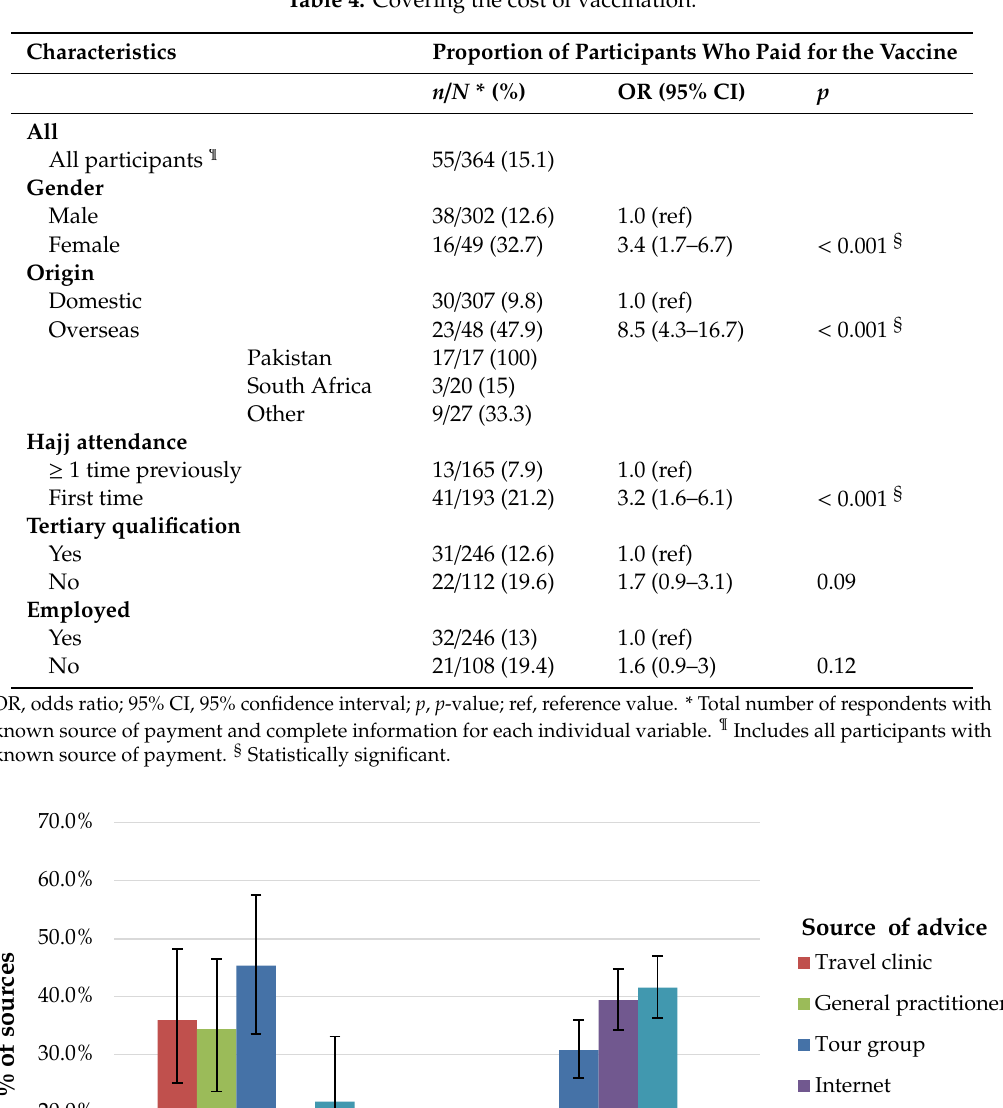
Table 4. Covering the cost of vaccination.